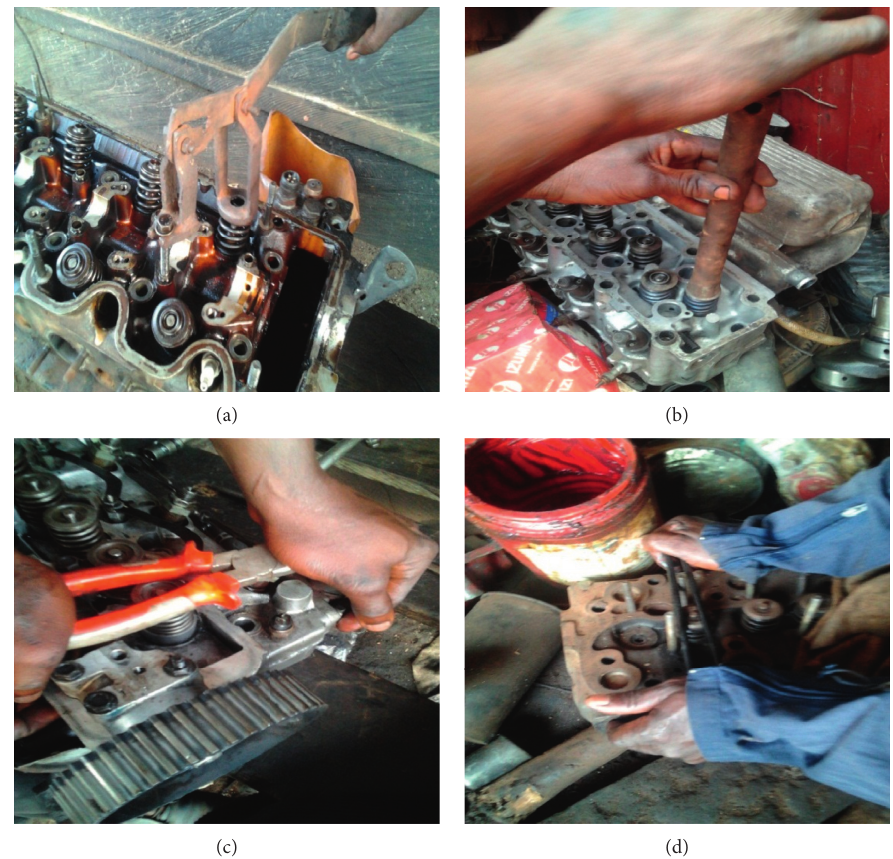
Figure 2: Methods of compressing valve spring. (a) Invented tool for spring compression. (b) Hollow pipe mostly used with a hammer. (c) A pair of pliers for spring compression. (d) Push rods as spring compressor.